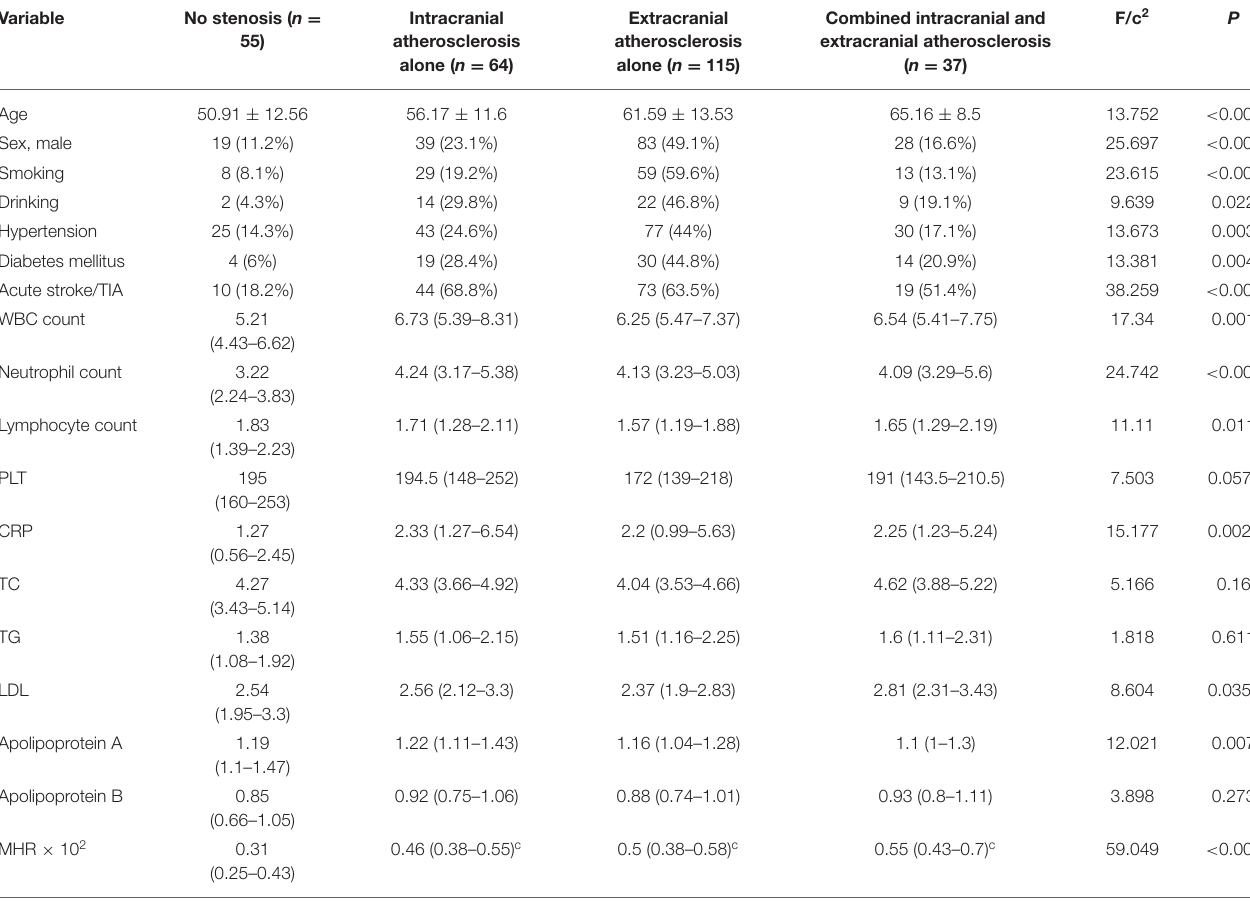
TABLE 3 | Associations of factors with the distribution of intracranial atherosclerotic stenosis.